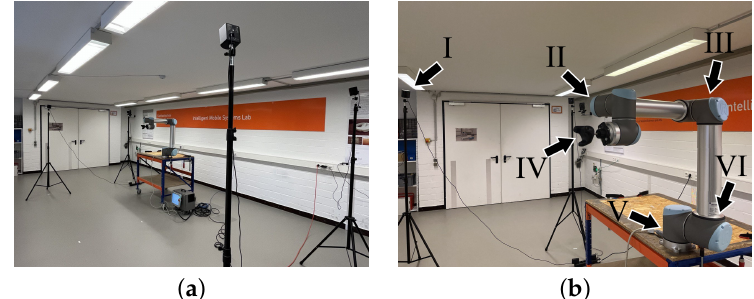
Figure 3. Experimental environment and setup: ( a ) overview of experimental environment and ( b ) details of experimental setup showing: (I) SteamVR Base Station 2.0, (II) Universal Robots UR10 robot arm wrist, (III) robot arm elbow, (IV) mounted VIVE Tracker (3.0), (V) robot arm base, and (VI) robot arm shoulder.